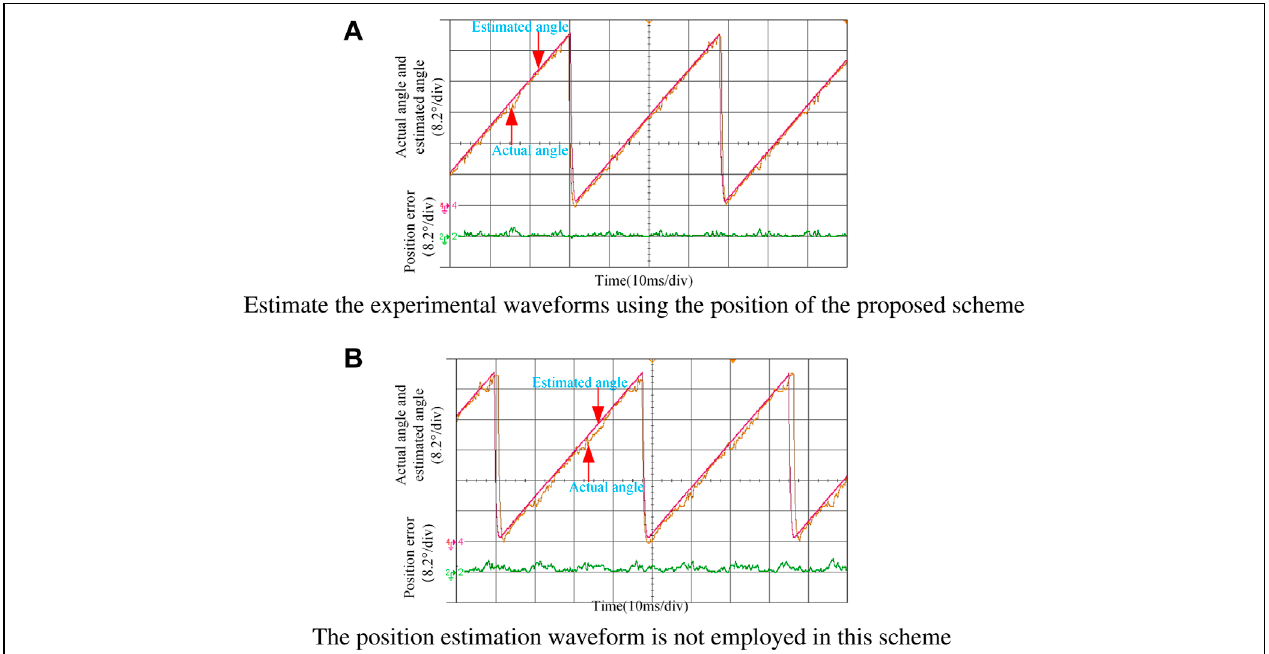
FIGURE 12 | Experimental waveforms of rotor position estimation with fractional load. (A) Estimation of the experimental waveforms using the position of the proposed scheme. (B) Position estimation waveform is not used in this scheme.